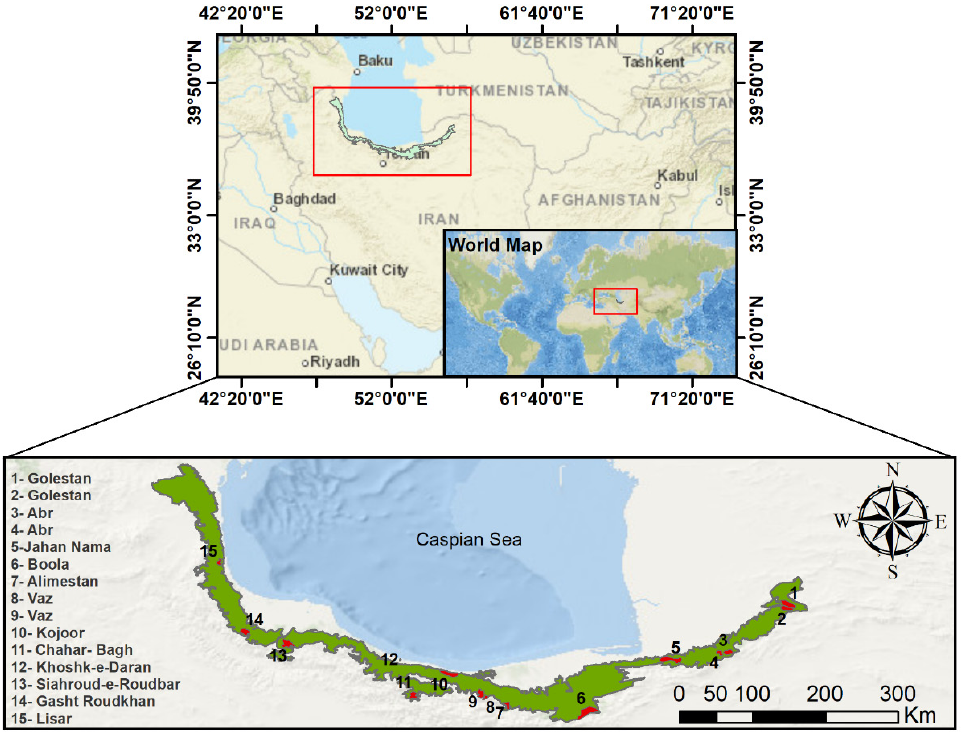
Figure 1. Vector map showing coverage area of UNESCO-inscribed sites across HF.